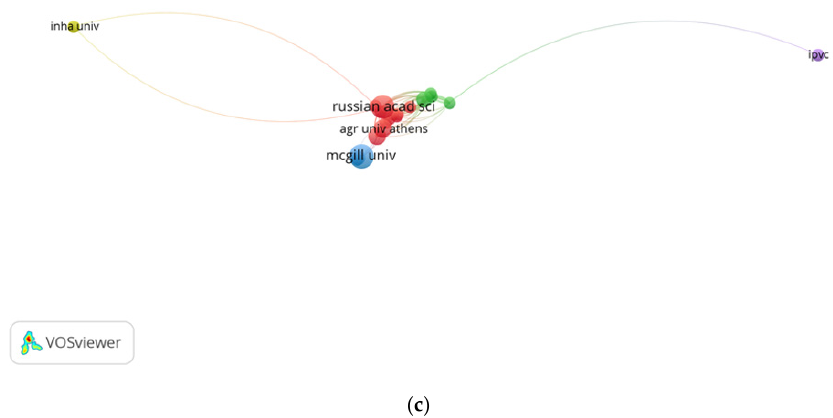
Figure 2. Bibliographic coupling analysis of ( a ) journals, ( b ) authors, and ( c ) institutions.